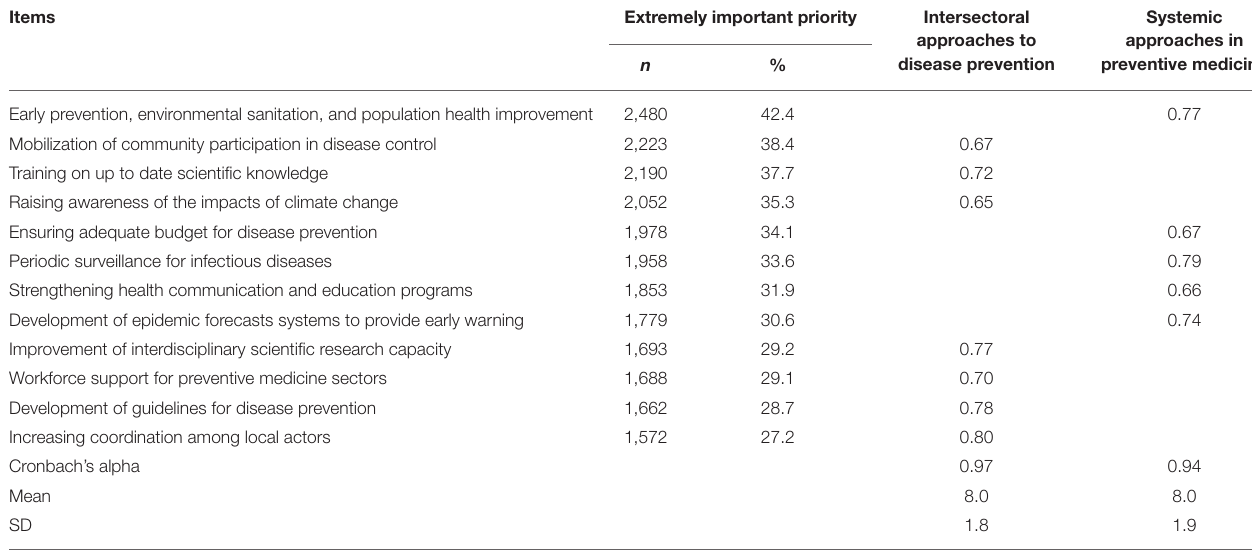
TABLE 2 | Participant satisfaction with and exploratory factor analysis of measures for disease control.